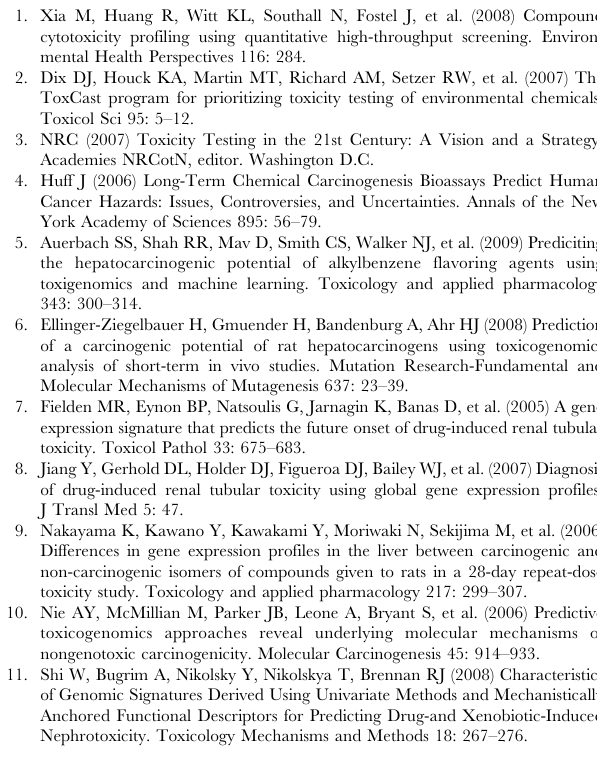
Table S1 List of rat hepatocarcinogen treatment groups from Auerbach et al., 2009. Table S2 List of chemicals in Table 1 that were chosen to be in each of the 5 folds in the cross-validation analysis performed. Table S3 List of various learning algorithms attempted in the SuperLearner package [ 35 ] and the cross-validat- ed risk for the case of pathway-based continuous predictions. Table S4 The list of pathways used as predictors along with their importance measures as reported by the random forests learning algorithm [ 37 ] . The importance measures for each of the pathways are also